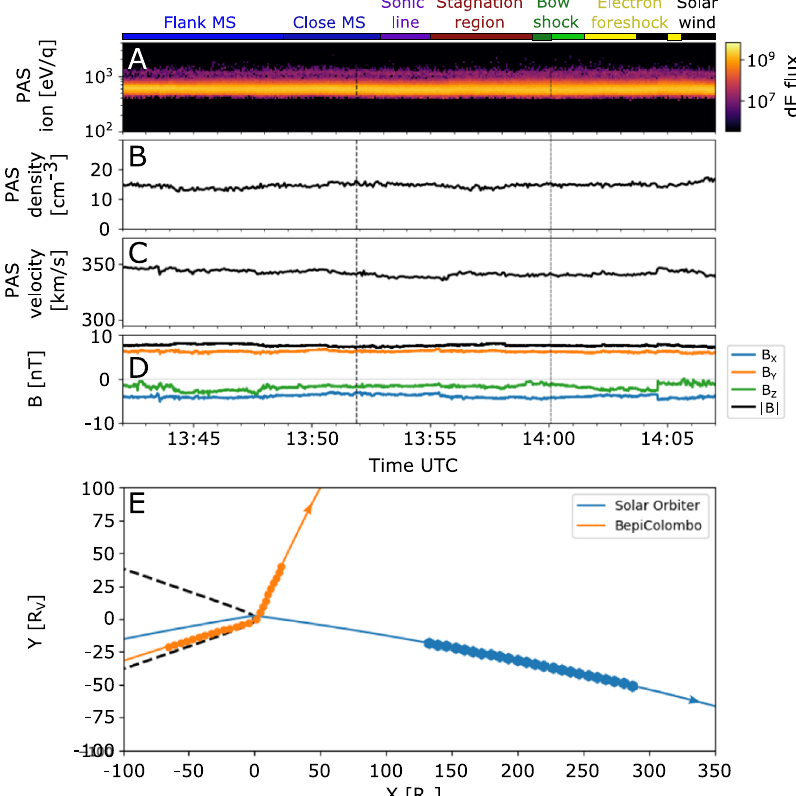
Fig. 4 | Measurements of the solar wind plasma and magnetic fi eld made by Solar Orbiter upstream of Venus on August, 10 2021, shifted to the BepiCo- lombo position (1h shift). A Time-Energy spectrogram of PAS proton energy differential fl ux[cm − 2 s − 1 eV/eV],( B )protondensity,( C )protonspeed,( D )magnetic fi eld components in the VSO coordinate system. ( E ) Location of the Solar Orbiter (blue, one symbol per hour) and BepiColombo (orange, one symbol per hour) in